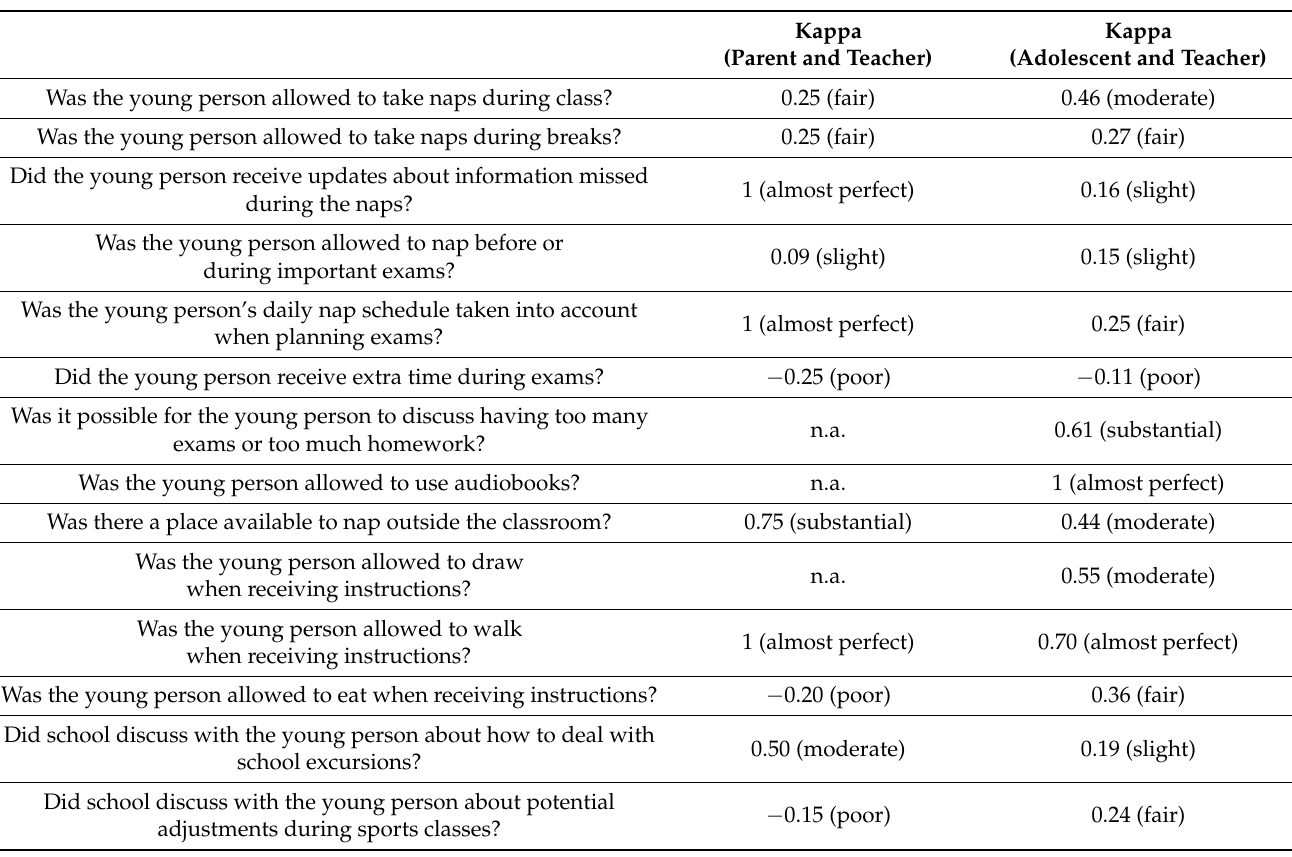
Table A1. Agreement between parents, teachers and students about arrangements made about interventions at